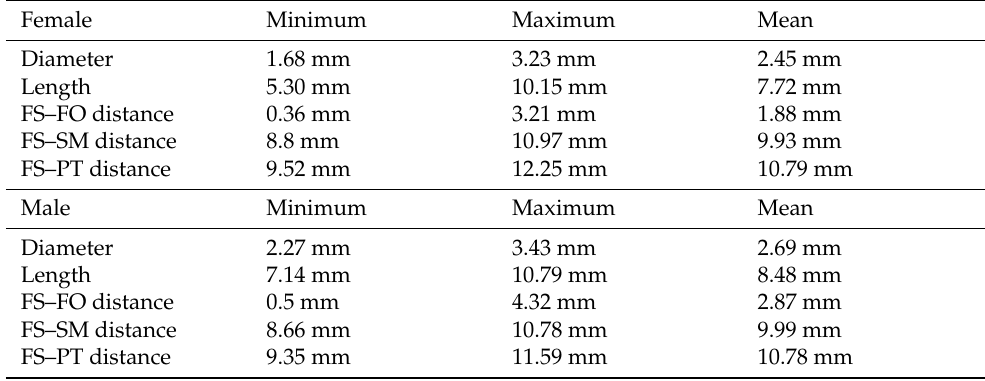
Table 2. Dimensions of the foramen spinosum (FS) on the left side and its distance from the foramen ovale (FO), midpoint of the skull base (SM), and pharyngeal tubercle (PT). Female Minimum Maximum Mean Diameter Length FS–FO distance FS–SM distance Male Minimum Maximum Mean Diameter Length FS–FO distance FS–SM distance FS–PT distance